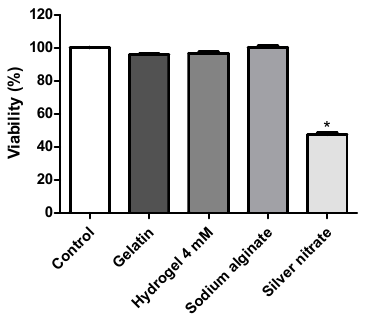
Figure 5. Cell viability assay of gelatin, hydrogel containing 4 mM of AgNPs, sodium alginate, and silver nitrate of human L929 fibroblasts, determined by the methyl-thiazolyl-tetrazolium (MTT) assay after 24 h of incubation. The vehicle used to dilute the drug (dimethyl sulfoxide, DMSO 5%) was used as the negative control (100% viability). The data correspond to the mean ± SEM of four independent experiments. * p < 0.05 compared to the control group using one-way analysis of variance followed by Tukey’s test. The antimicrobial activity test was performed in vitro using Gram-positive ( Staphylococcus aureus ) and Gram-negative ( Pseudomonas aeruginosa ) bacteria. MIC tests performed with gelatin, sodium alginate, silver nitrate, and hydrogel (1, 2, and 4 mM) are shown in Table 1. Gelatin and